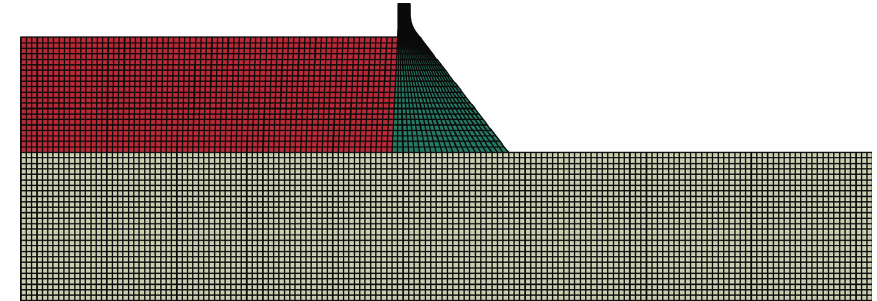
Figure 6: FE mesh of the Pine Flat dam-reservoir-foundation system.